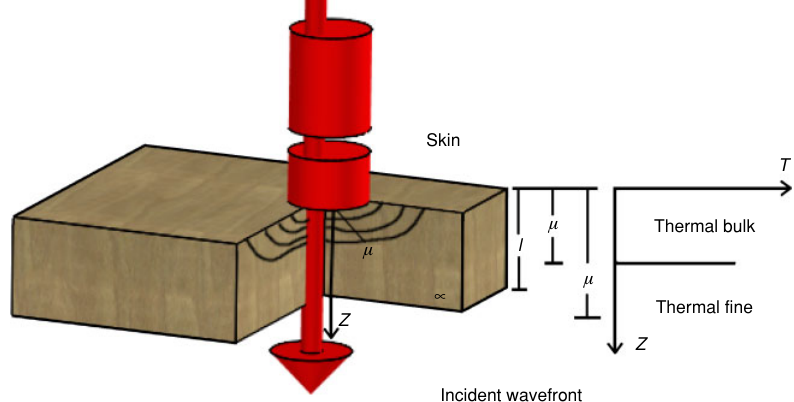
Figure 1 Behavioral illustrations of fine and bulk thermal materials.